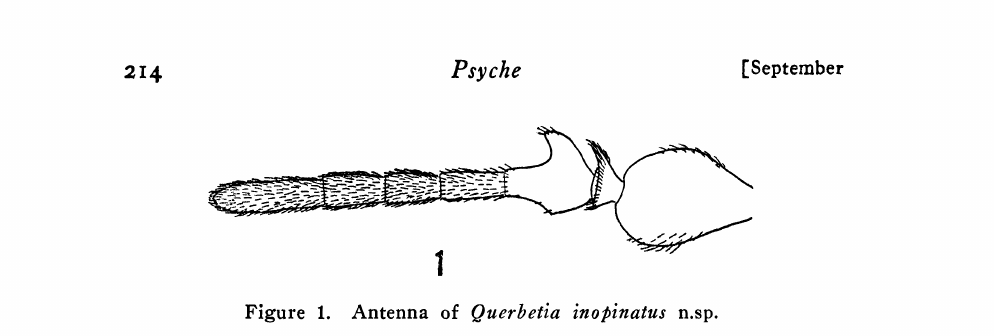
Figure 1. Antenna of Querbetia ino#inatus n.sp.